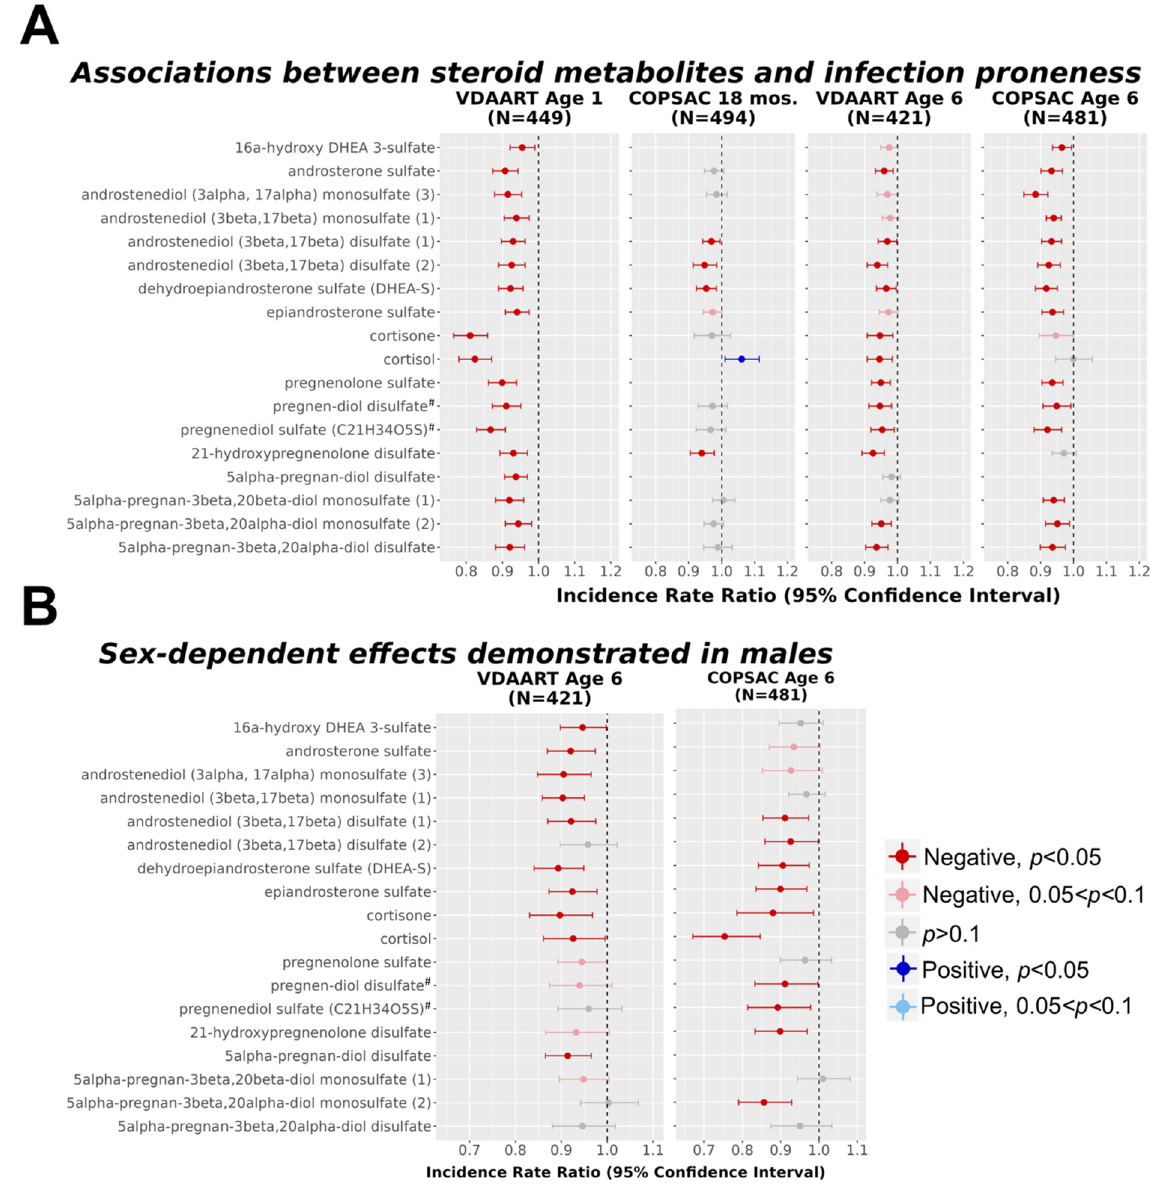
Figure 2. Reduced plasma steroid metabolites were associated with higher infection proneness and males demonstrated further reduction at age 6 years. ( A ) Poisson regression analysis was used to determine association between steroid metabolites and infection proneness across two time points: infancy (aged 1 year/aged 18 months) or early school age (aged 6 years). Models were adjusted for sex, race, ethnicity, study site, BMI, steroid medication use within 3 months of blood draw, and year 6 vitamin D level (italicized = covariate only in VDAART); fish oil intervention status was included as a covariate for COPSAC only; ( B ) Interaction coefficients are shown for interactions between steroid metabolites at age 6 years and sex. Metabolite names marked with a superscript hash sign (#) denote metabolite identification at tier 2 level (matching Metabolon database, details in Methods).